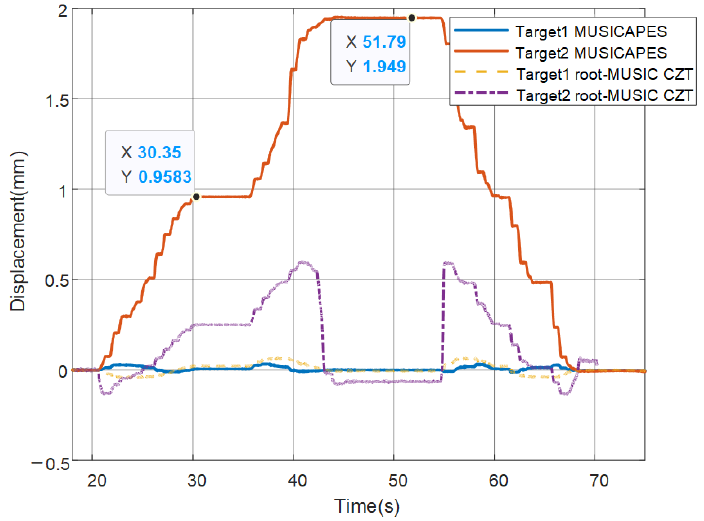
Figure 17. Displacement curves of the two trihedral reflectors estimated by the MUSICAPES and the CZT method. Target 1 is the still reflector and Target 2 is the moving one mounted on the sliding